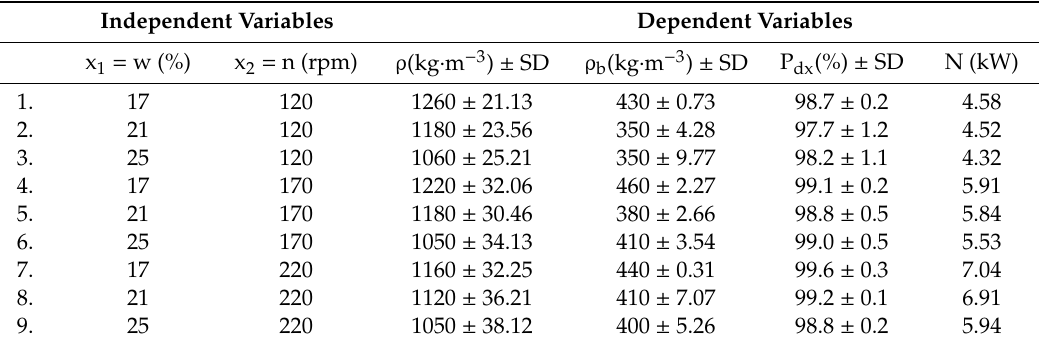
Table 3. Results of densification tests fortobacco